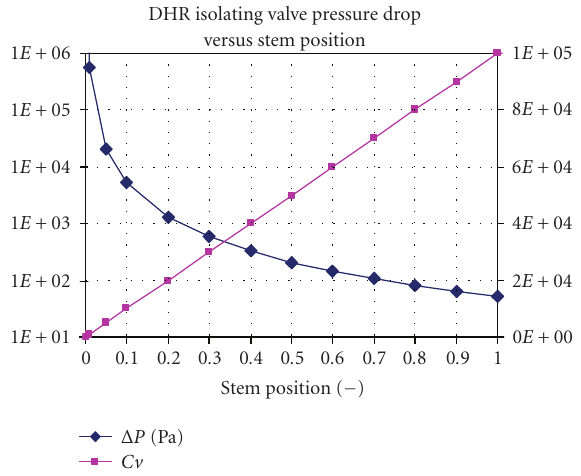
Figure 19: Fuel and gas temperature evolutions versus additional pressure drop in the DHR loop.